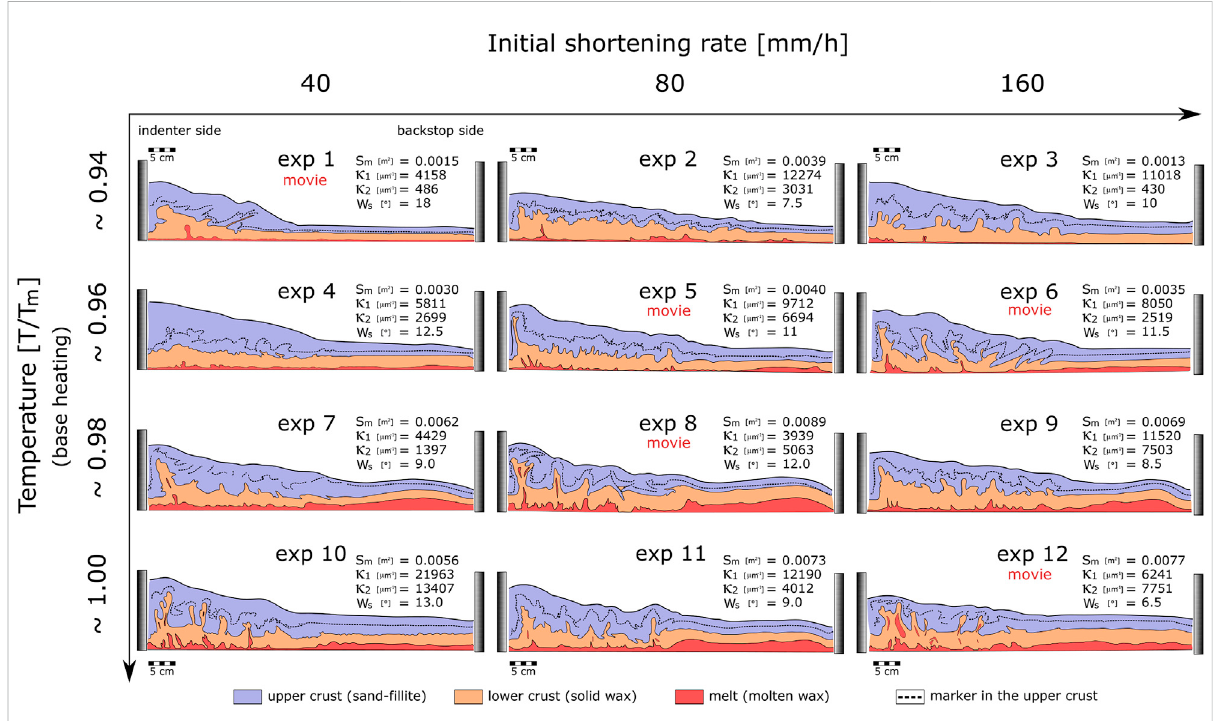
FIGURE 4 The resultant architecture of the performed experiments. Each experiment is associated with unique quanti fi ers that describe surface area of themelt( Sm ),curvatureofupper-lowercrustboundary(